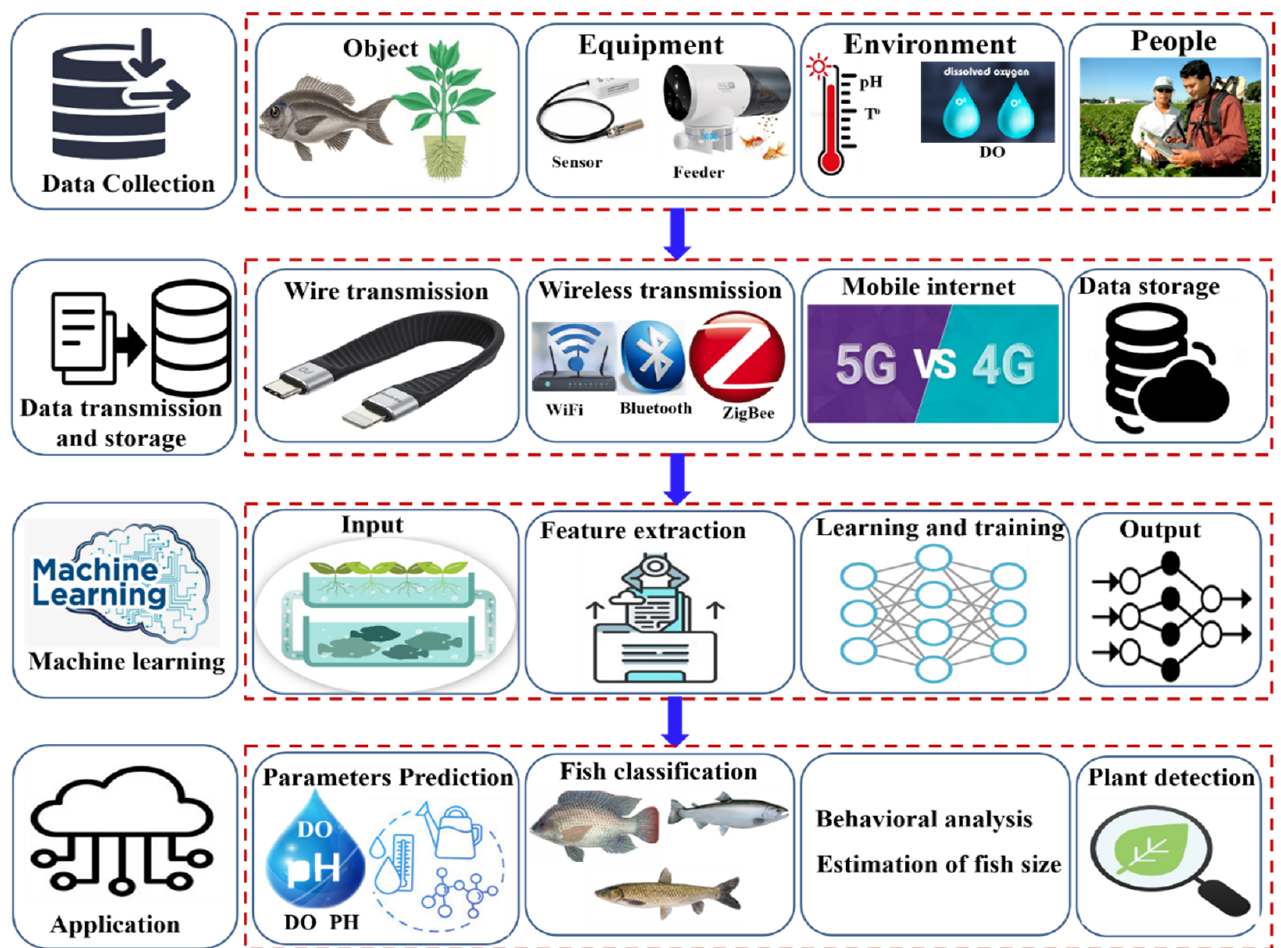
Figure 6. Neural networks and deep-learning-enabled advanced analytics applied for different tasks in smart aquaponics.